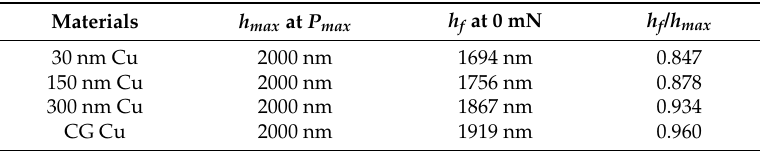
Figure 2. Several load-displacement ( P-h ) curves obtained at an indentation depth of 2000 nm at L of 0.04/s in the NC/UFG/CG Cu. Table 1. h f / h max of NC/UFG/CG Cu obtained at a strain rate of 0.04/s and indentation depth of 2000 nm.